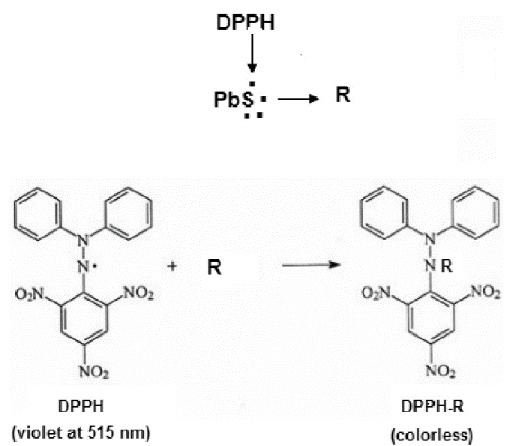
Scheme 1. Capture mechanism of DPPH radical. Table 2. Radical DPPH scavenging capacity (SC) of